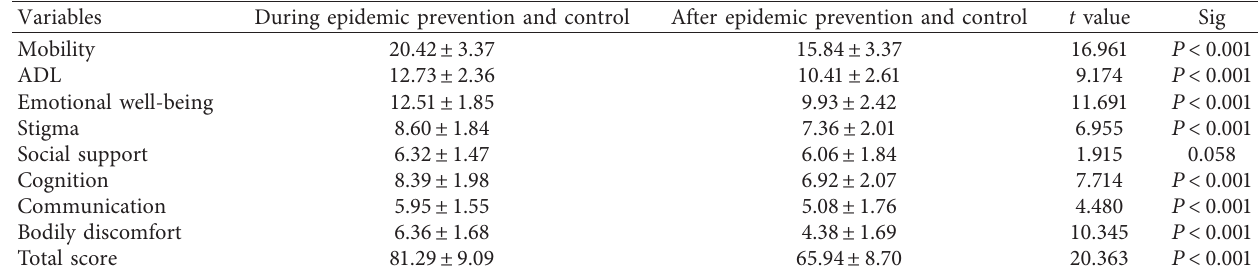
Table 2: Comparison of all PDQ-39 domain outcomes of 108 patients between during and after epidemic prevention and control.